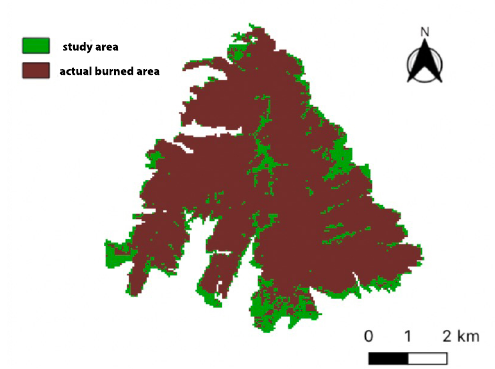
Figure 6. The actual burned area of the forest fire.